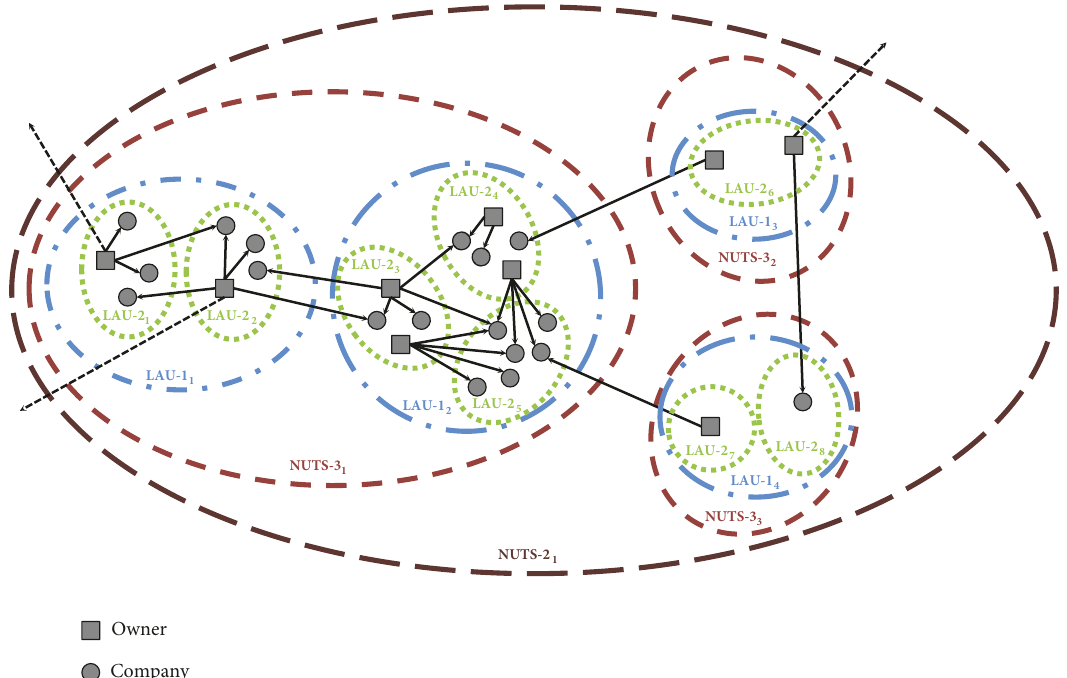
Figure 1: Company-ownership relations connect the elements of the settlement hierarchy (Settlement (LAU 2), statistical subregion (LAU 1), small-region (NUTS 3), and region (NUTS